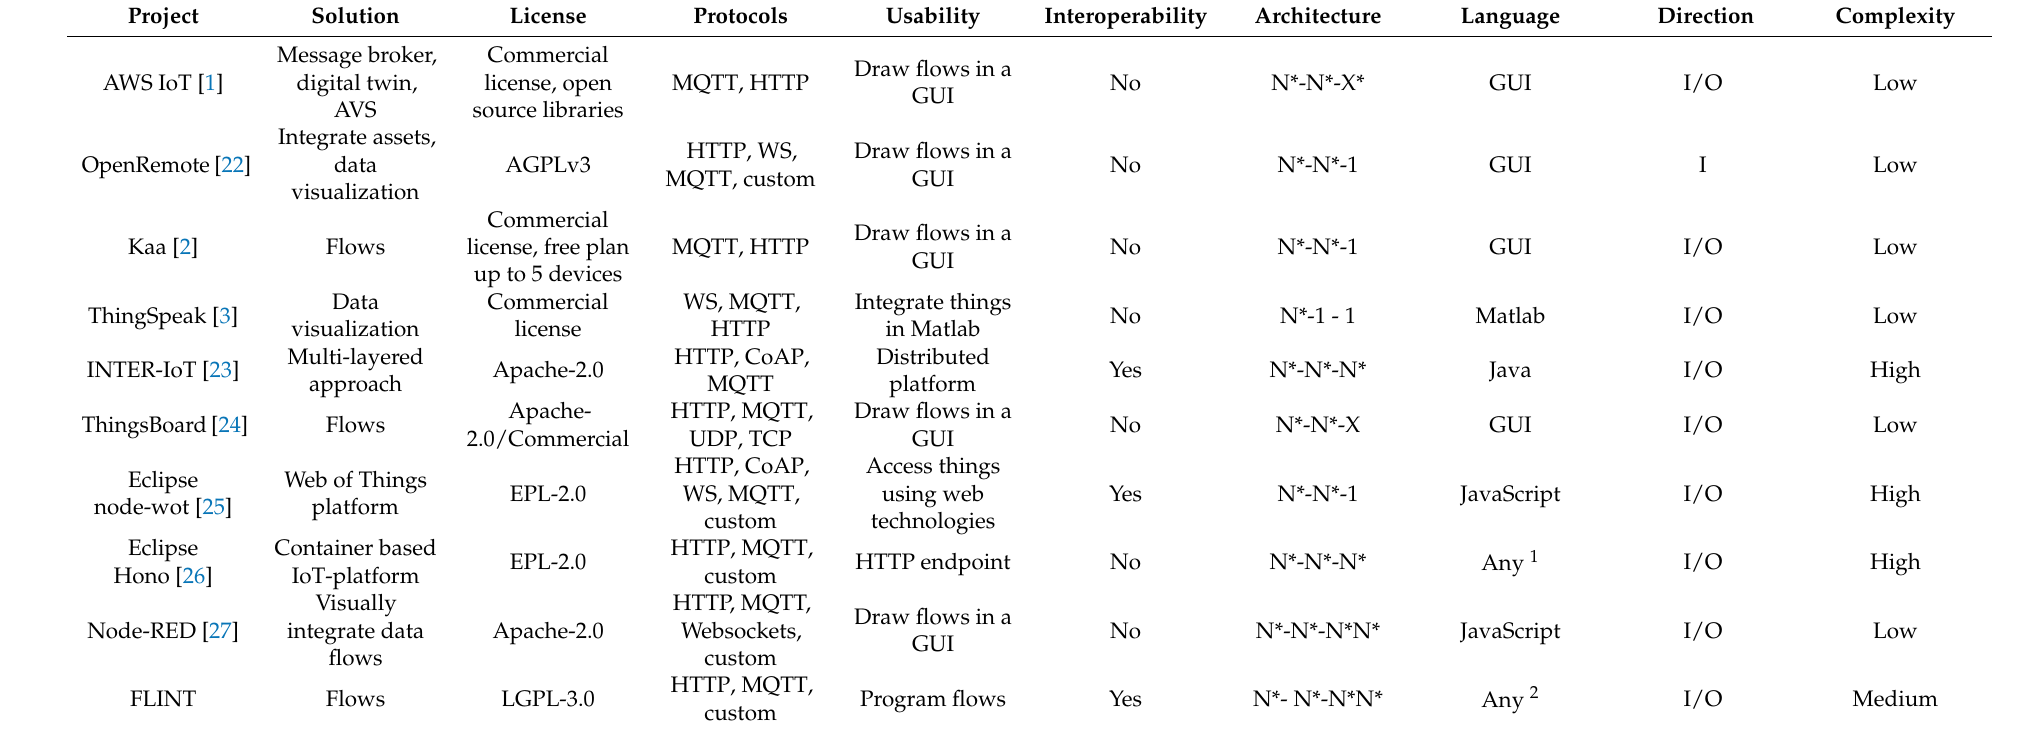
Table 1. Non-exhaustive list of commercial and open source IoT